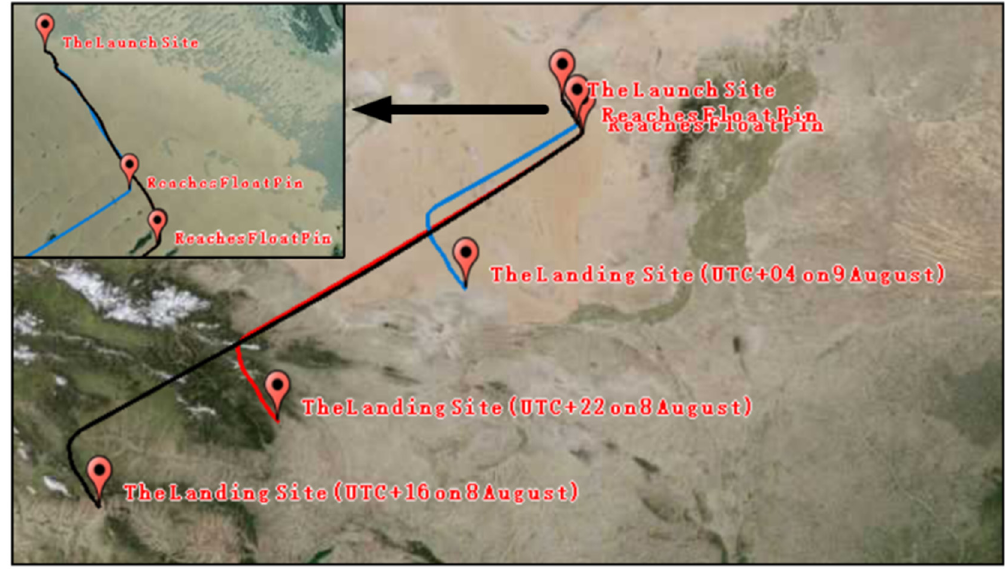
Figure 12. Trajectory predictions at different launch times of the day.